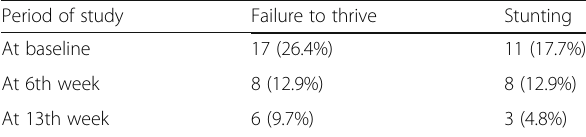
Table 7 Patients with failure to thrive and stunting Period of study Failure to thrive